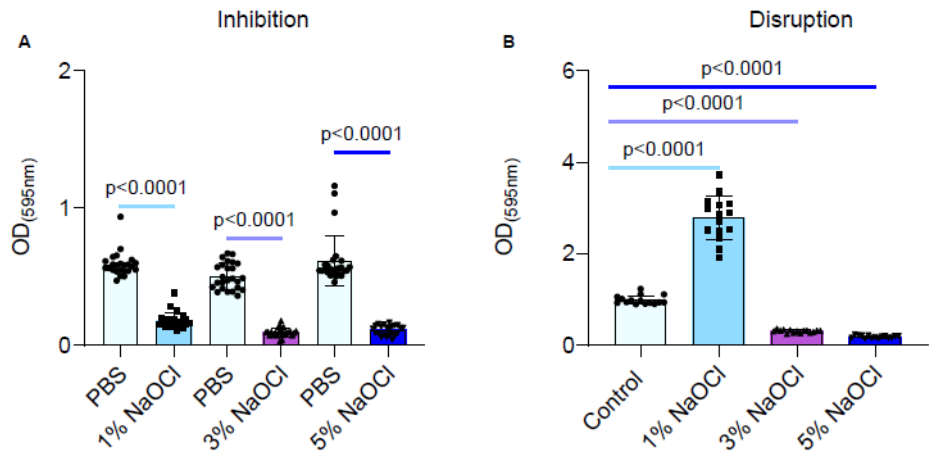
Figure 1. Different concentrations of NaOCl inhibited the biofilm formation of E. faecalis but failed to eradicate pre-established biofilms. Each color represents a different NaOCl concentration ( A ) E. faecalis cells were diluted 1:100 into a fresh TSB medium (untreated) or applied with different concentrations of NaOCl (1%, 3% or 5%). 100 µ L of cultures were split into a 96-well polystyrene plate and further incubated at 37 ◦ C for 24 h. Biofilm formation was assessed by crystal violet staining. ( B ) E. faecalis cells were diluted 1:100 into a fresh medium. 100 μ L of cultures were split into a 96-well polystyrene plate and further incubated at 37 °C for 24 h. The growth media was removed, and the remaining biofilm biomass was either untreated or treated with different concentrations of NaOCl (1%, 3%, or 5%) for 5 min. Biofilm was assessed by crystal violet staining. Graphs represent the mean ± SD from five biological repeats ( n = 25). Statistical analysis was performed using Brown – Forsthye and Welch’s ANOVA with Dunnett’s T3 multiple comparisons test. p < 0.05 was considered statistically significant.